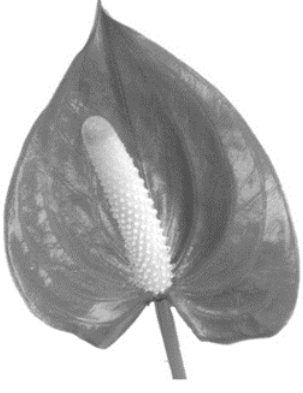
Figure 3. Athurium Figure 3. Athurium